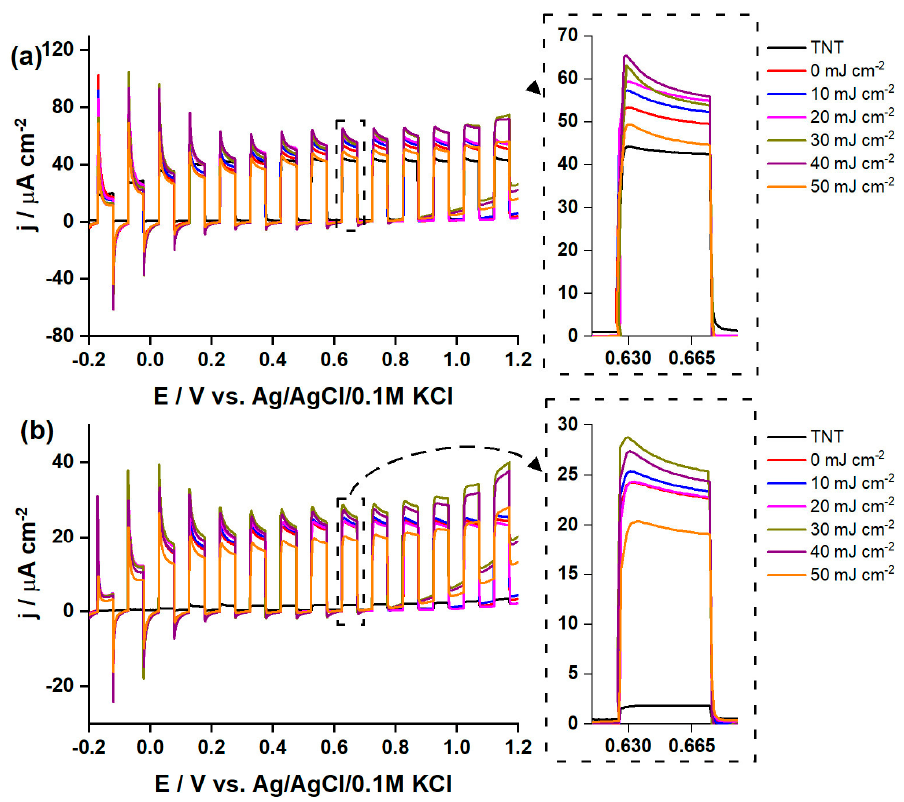
Figure 8. Linear voltammograms registered for the bare and modified titania nanotubes. The LV curves were recorded under chopped ( a ) UV-vis and ( b ) vis irradiation.